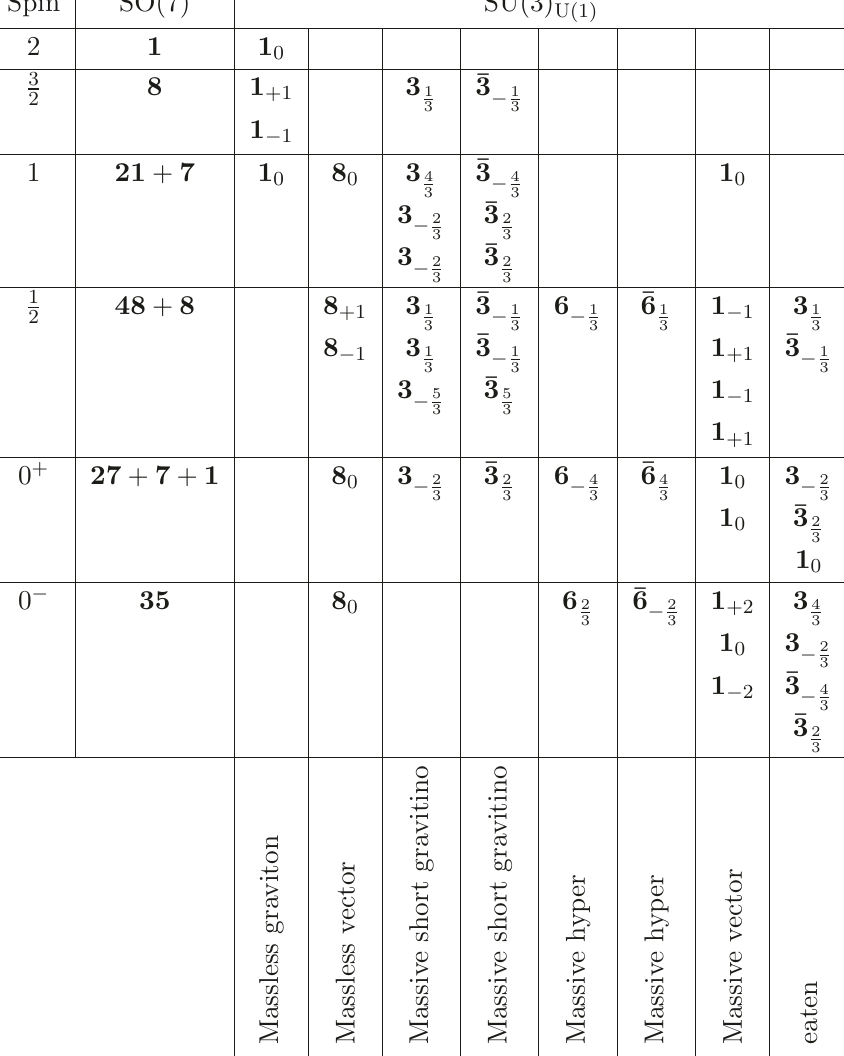
Table 3 . The OSp(4 gravity within the